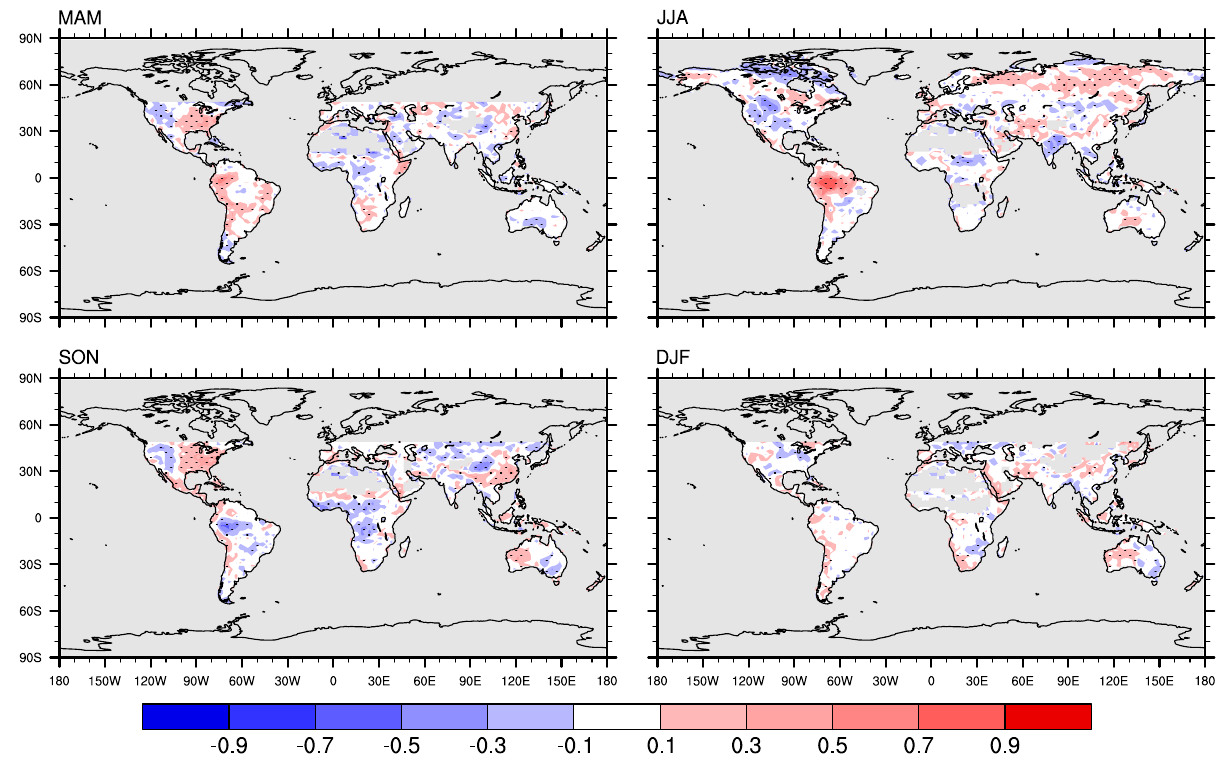
Figure 3. Observed correlation between monthly mean FLUXNET GPP and OMI HCHOv in 4 seasons: MAM, JJA, SON and DJF. Signifi- cant regions ( p <0.05) are shown with dotted